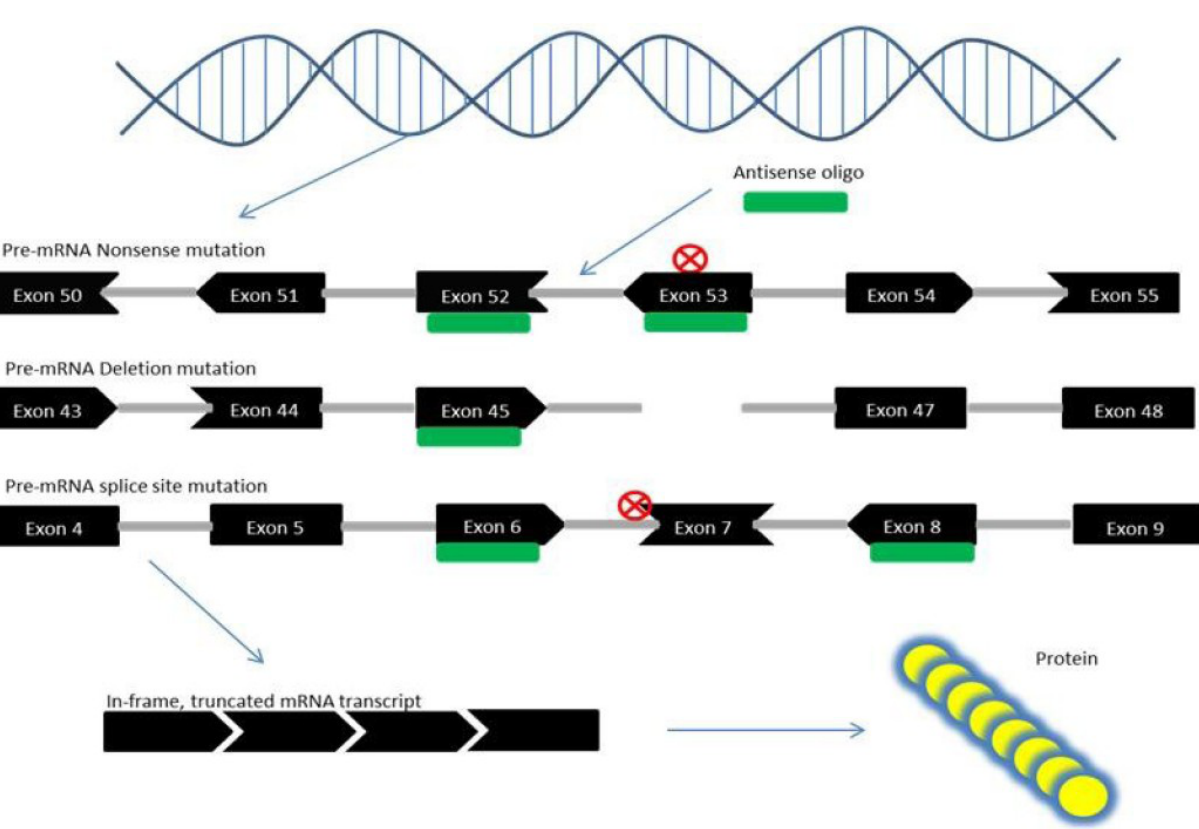
Figure 2. Mechanism of exon skipping therapy for Duchenne muscular dystrophy (DMD). Nonsense mutations in the DMD gene can create a novel STOP codon which results in the loss of DMD protein. Exon skipping corrects this error when exons (black) that are bound to antisense oligos (green) are spliced out of the pre-mRNA, and the resulting exon sequences ―fit together‖, i.e. , are in-frame (denoted by the shape of each exon—ends that fit together are in-frame). Out-of-frame mutations caused by the loss of exonic sequences, through deletion or splice site mutations, can also be corrected through exon skipping, which removes exons adjacent to the mutation site so that the remaining exons are in-frame. The result is a truncated yet partly functional protein, as in the case of Becker muscular dystrophy